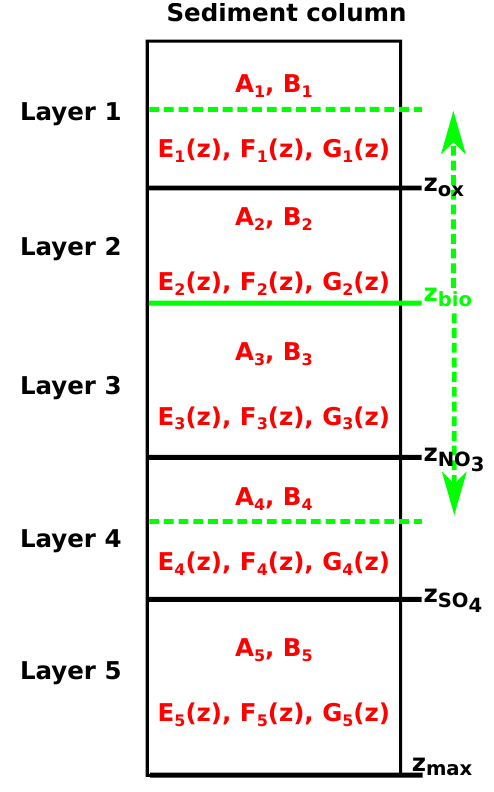
Figure 3. Schematic of the generic boundary condition matching (GBCM) problem. Shown are the resulting integration constants ( A i , B i ) and ODE solutions ( E i , F i , G i ) for the different sedi- ment layers and the bioturbation boundary (possible locations are indicated by the green vertical